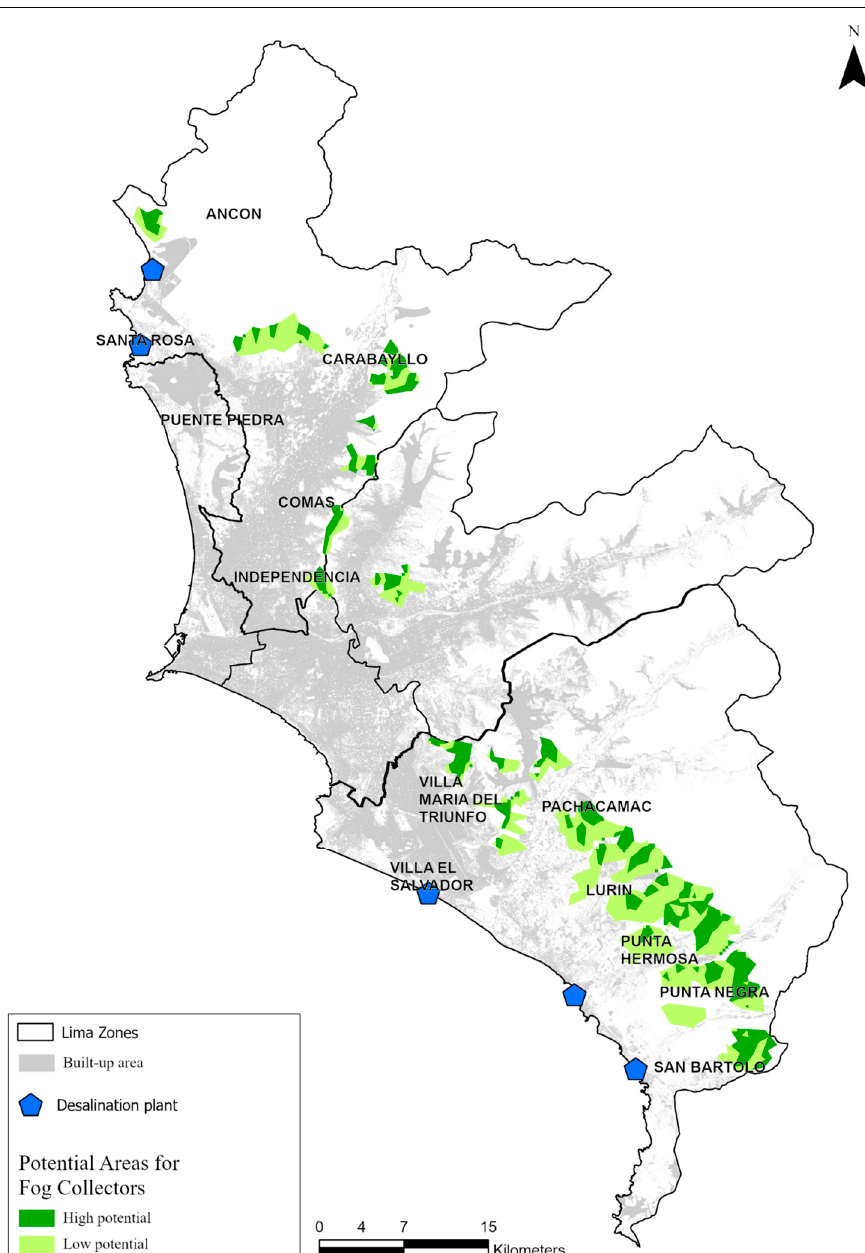
Figure 7. Location of the proposed solutions as part of the WSUP for Lima North and South. The map shows the built-up area by 2021 and the proposed location of desalination and fog collector parks in fast-growing districts.